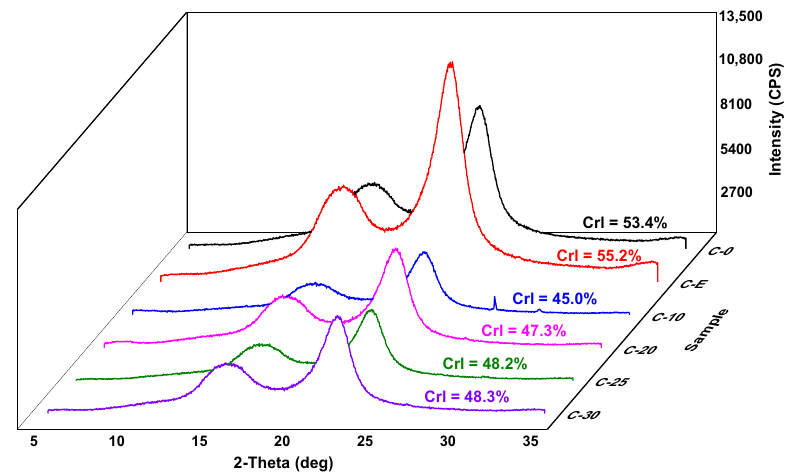
Figure 4. XRD patterns of nano/microfibrils films with different treatment stages.